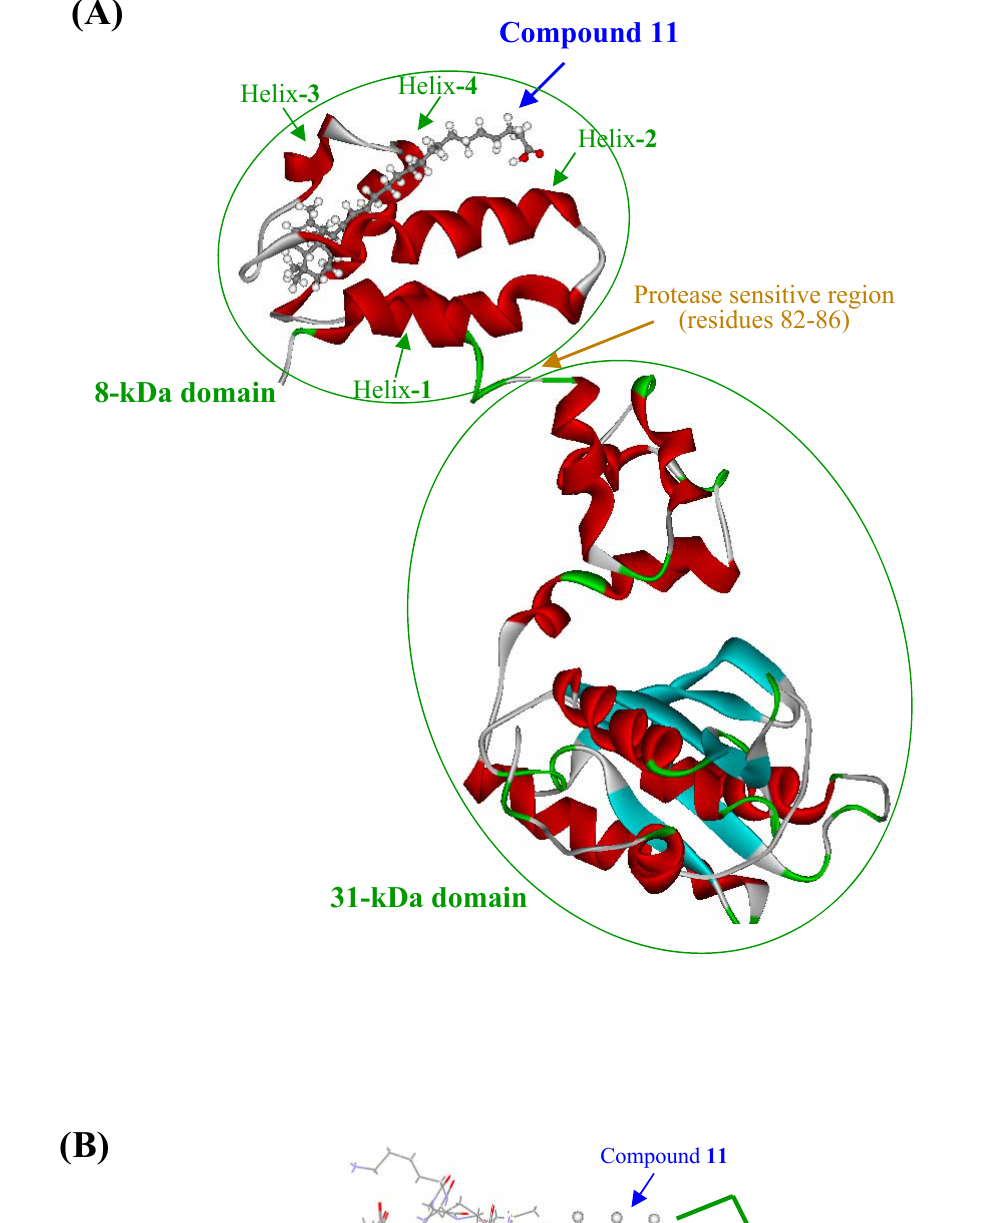
Figure 4. Docking simulation of compound 11 with rat DNA polymerase β